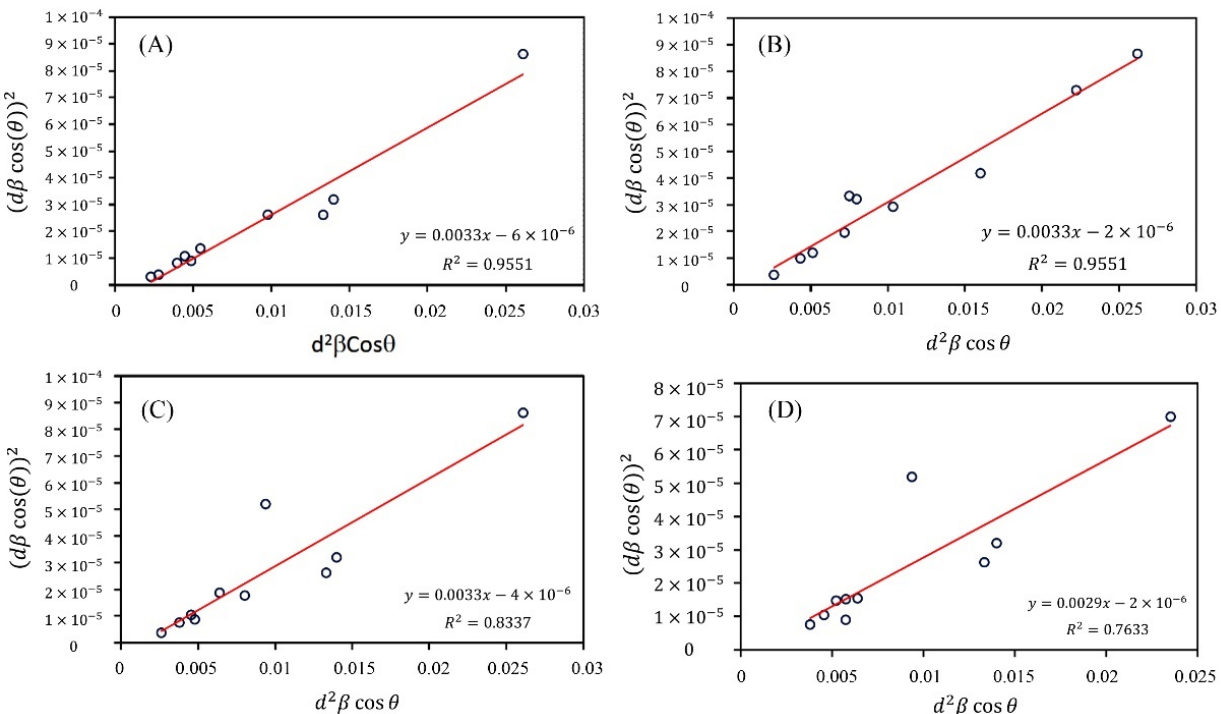
Figure 5. SSP plot for the ZNO hexagonal diffraction peaks, Zn 1 − x Ag x O ( A ) x = 0.0, ( B ) x = 0.03, ( C ) x = 0.06 and ( D ) x = 0.09.